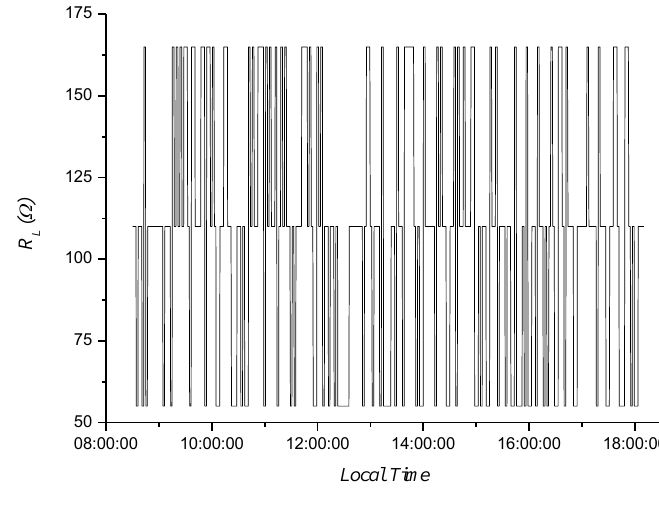
Figure 9. Variable load profile.